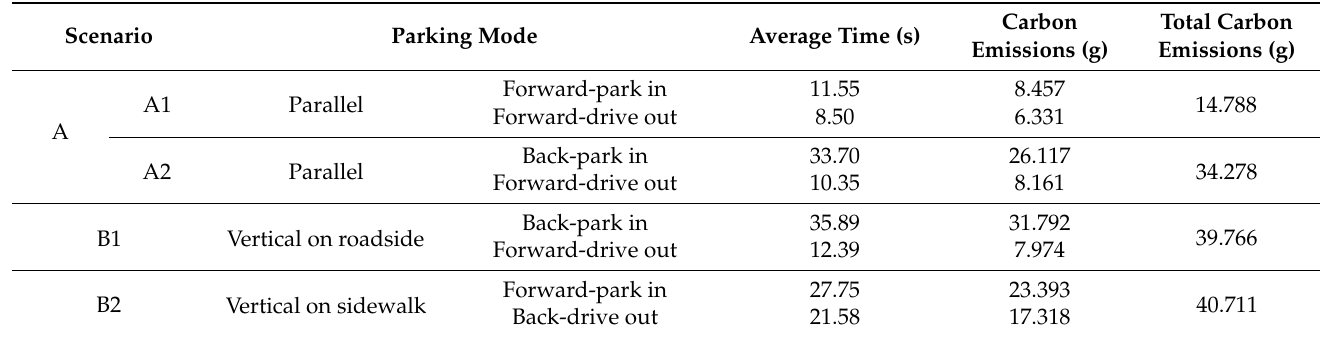
Table 3. Basic carbon emissions from typical roadside parking